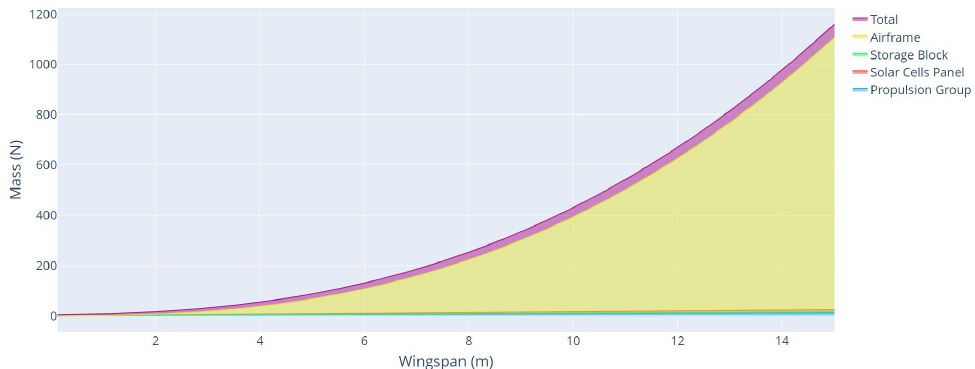
Figure 15. Aircraft mass as a function of wingspan without climbing power.